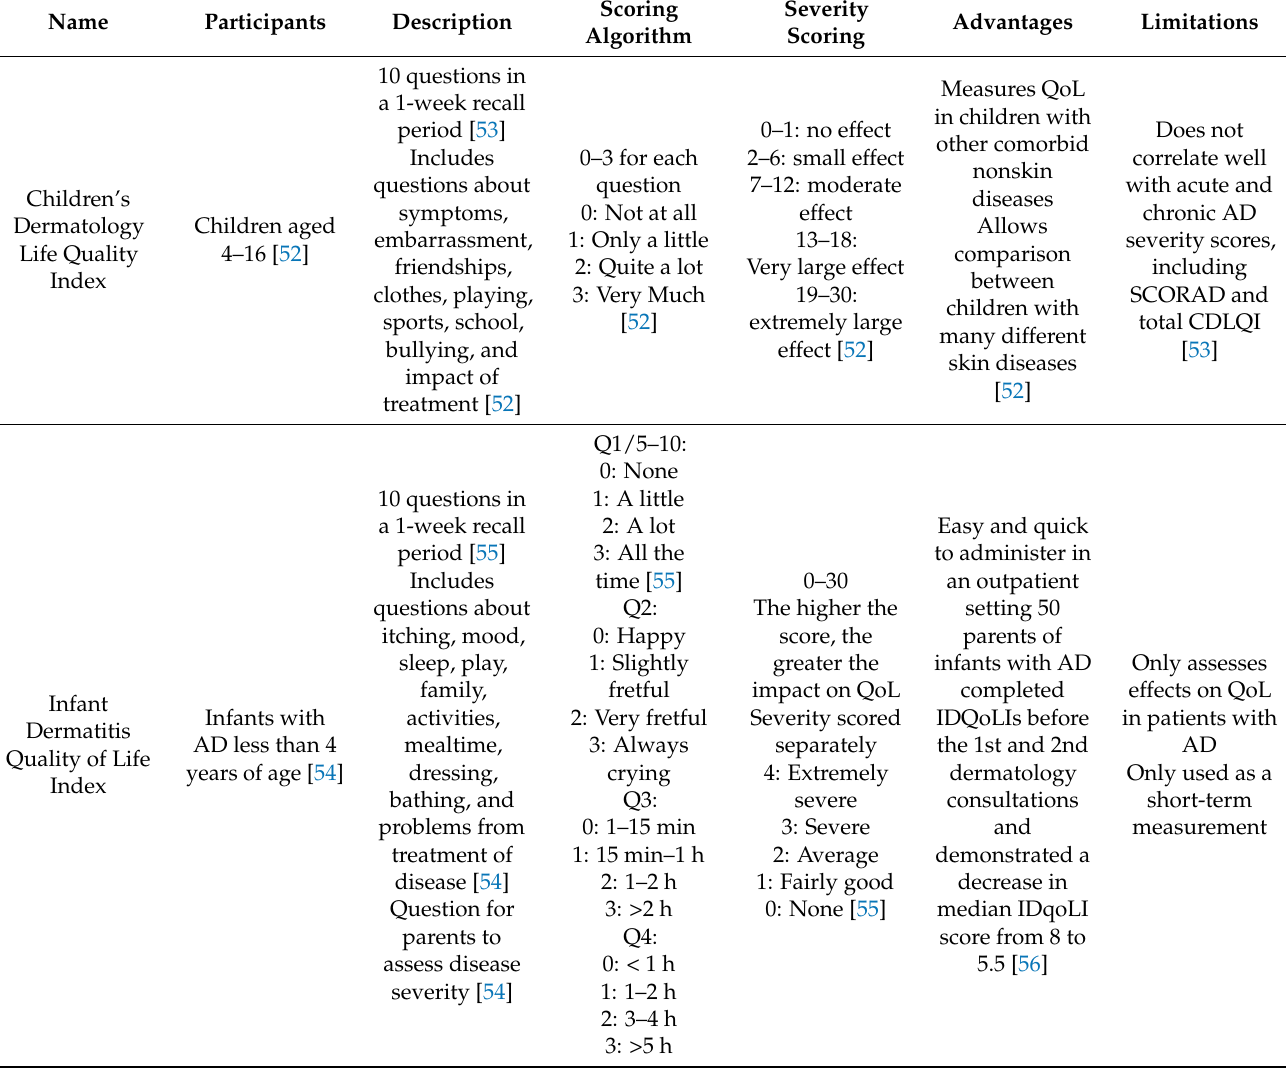
Table 1. Current Quality of Life Measurement Tools for Pediatric Dermatologic